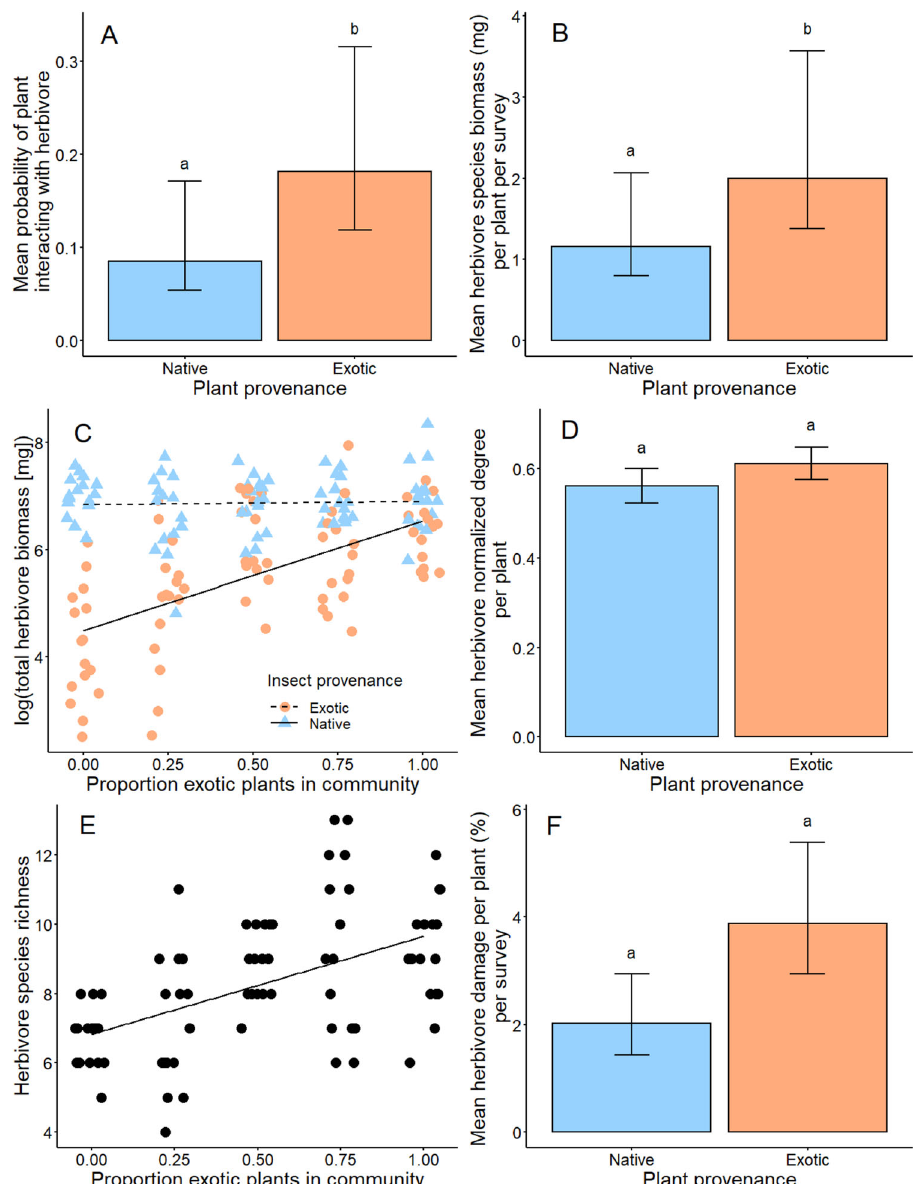
Fig. 2 Plant – herbivore interactions of native and exotic plants and their composite communities in the mesocosm experiment. A Herbivore species were twice as likely to interact with exotic (orange, n = 2876 potential plant – herbivore interactions, with 961 realised) than native (blue, n = 2652 potential plant – herbivore interactions, with 646 realised) plant species within their fundamental host range ( F = 5.93, P = 0.015). B Mean herbivore species biomass was 72% higher on exotic ( n = 1333 plant – herbivore interactions) than native ( n = 809 plant – herbivore interactions) plant species ( F 1,41 = 24.71, P = 0.0001). C Exotic herbivore total biomass per mesocosm (log-transformed; orange circles) increased with the proportion of exotic species planted into mesocosm communities (slope = 1.78, t = 4.29, P = 0.00009), whereas no relationship was observed for native herbivores (blue triangles, slope = 0.28, t = 0.68, P = 0.501; plant provenance× herbivore provenance interaction: F = 43.67, P = 8.4e − 10 ; n = 80 mesocosms per herbivore provenance). 1,134 D Mean herbivore species richness (quanti fi ed as normalised degree, the proportion of interactions observed out of all possible interactions) did not differ between native ( n = 193) and exotic ( n = 242) plants ( F 1,48 = 1.35, P = 0.251). E Herbivore species richness of mesocosm communities ( n = 80) increased with the proportion of exotic plant species planted (slope = 0.41, F 1,18 = 9.65, P = 0.002). F Mean percent chewing and scraping damage to leaf tissue from invertebrate herbivores did not signi fi cantly differ between native ( n = 320) and exotic ( n = 320) plants ( F = 12.76, P = 0.062). Different lowercase letters indicate signi fi cant differences ( P < 0.05) between back-transformed estimated marginal means (±SEM) from (generalised) linear mixed models. Scatterplot linetypes indicate slopes that signi fi cantly differ from zero (solid lines, P < 0.05) or do not (dashed lines). A small amount of jitter has been added to separate overlapping points on the x-axis. Corresponding violin plots showing the distribution of raw data are presented in Supplementary Fig.